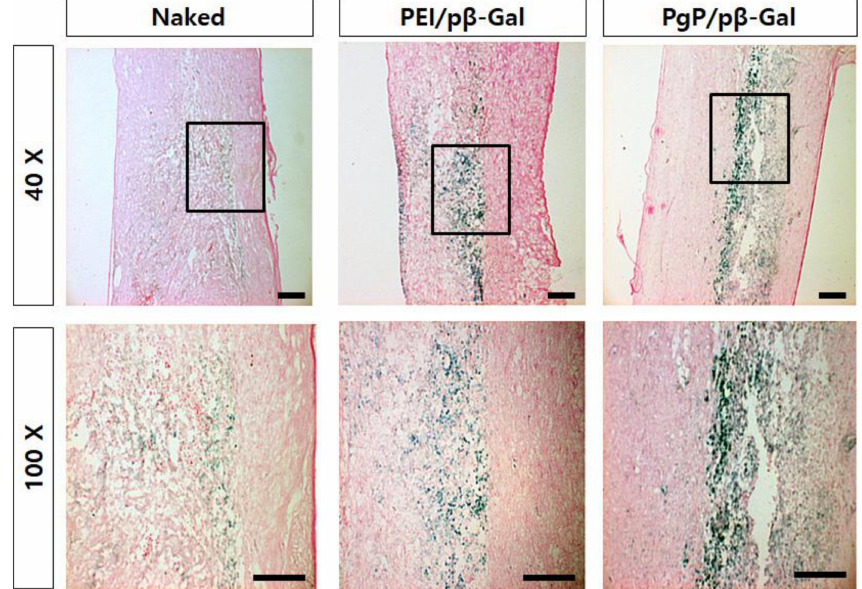
Figure 6. Representative images of β -Galactosidase-positive cells at 7 days post-injection of PgP / p β -Gal polyplexes (N / P of 60 / 1) in rat T5 spinal cord tumor in vivo. (left) Naked p β -Gal, (middle) bPEI / p β -Gal polyplexes at N / P of 5 / 1, and (right) PgP / p β -Gal polyplexes at N / P of 60 / 1. Original magnification: ( Top ) 40 × and ( Bottom ) 100 × . Scale bars indicate 100 µ